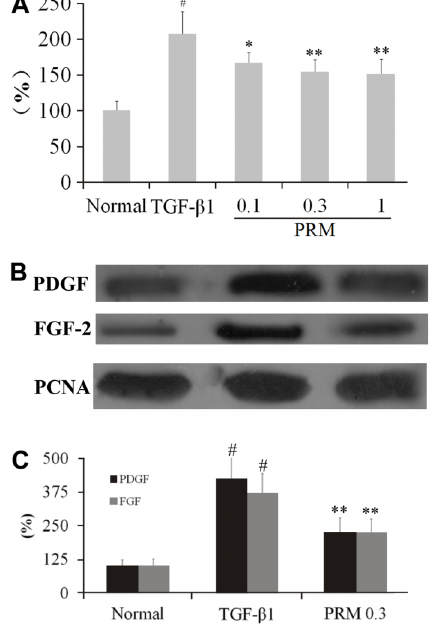
Figure 4. Effects of pulmonary rehabilitation mixture (PRM) on human lung fibroblasts (HLF)-1 proliferation, fibroblast growth factor (FGF)-2 and platelet-derived growth factor (PDGF) expression. A , Effects of PRM on HLF-1 proliferation. Cell proliferation was tested by MTT when they were treated with 5 ng/mL transforming growth factor (TGF)- b 1-stimulated HLF-1 for 48 h. B , C , HLF-1 was incubated with TGF- b 1 (5 ng/mL) for 48 h and FGF2 and PDGF expression were analyzed by Western blotting. Data are reported as means±SD. PCNA: proliferating cell nuclear antigen. # P , 0.01 vs the normal group; *P , 0.05, **P , 0.01 vs the TGF- b 1 group (one-way ANOVA followed by Dunnett’s test).